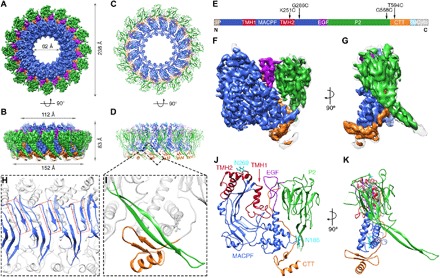
Cryo-EM structure of the PFN2 pre-pore oligomer.(A and B) Cryo-EM map of the mPFN2 pre-pore at 3.5 Å resolution as viewed from the top (A) and the side (B), color-coded by different domains (MACPF in blue, EGF in purple, P2 in green, and CTT in orange). (C and D) Top and side views of the atomic model of the mPFN2 pre-pore shown as ribbons; domains are colored as in (A). (E) Domain organization of the mPFN2: SP, signal peptide; TM, transmembrane helix; and Cyto, cytosolic tail. (F and G) Cryo-EM map of one subunit of the pre-pore colored as in (A). (H) The β sheet formed between MACPF domains marked with a dashed rectangular box. (I) Close-up view of the four-stranded β sheet formed between the CTT and the adjacent P2. (J and K) Ribbon representation of the pre-pore subunit as colored in (A); TMH-forming α helices are colored in red, and the conserved N-link glycans are colored in cyan.